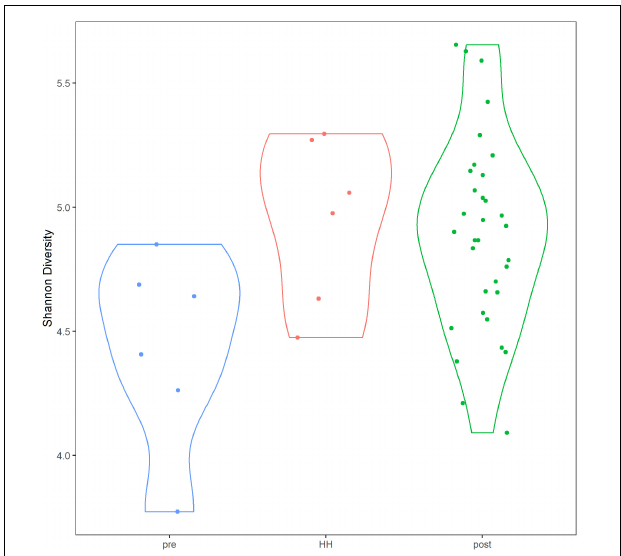
FIGURE 5 | Alpha diversity in Clear Lake system before and after Hurricane Harvey. Y -axis indicates Shannon diversity indices. Categories correspond to before (pre), immediately after (HH) and more than a week after (post). Figure was generated with scripts in Supplementary File 5